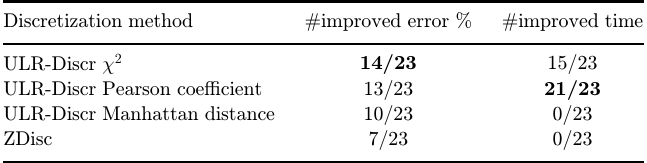
Table 10. Overall comparison of the ULR-Discr variants with ZDisc.